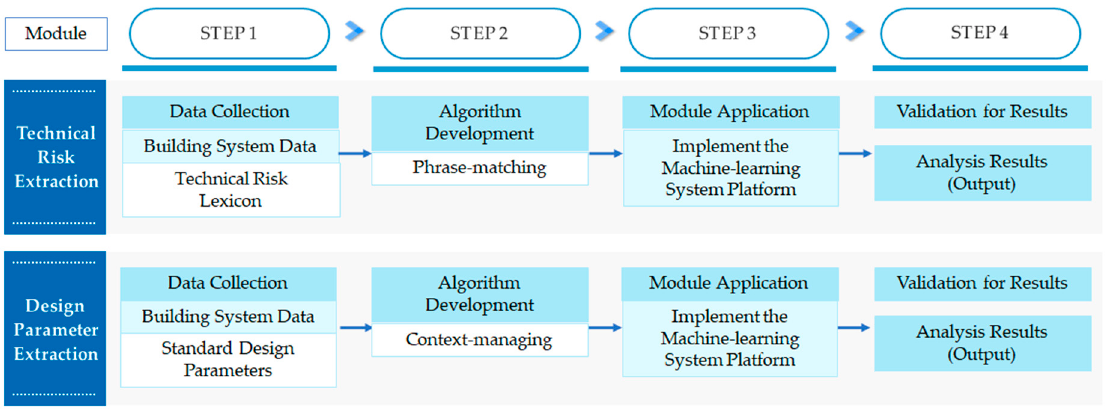
Figure 1. Research steps and process methodology.